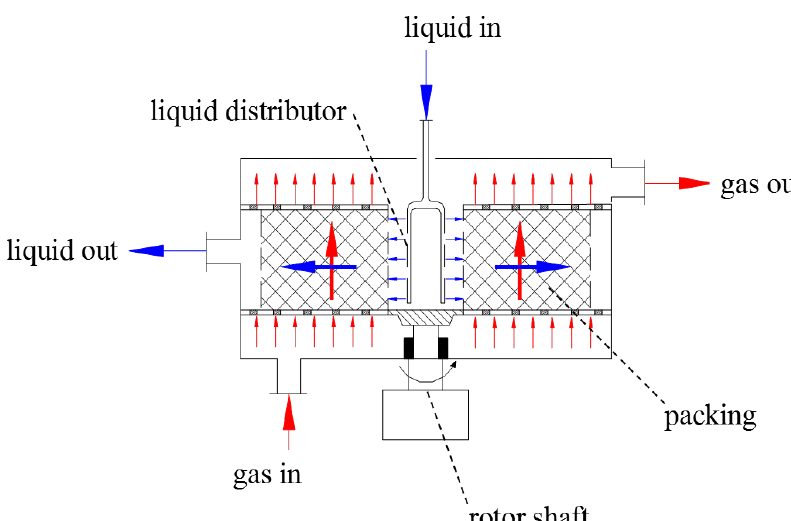
Figure 1. Main structure of a cross-flow rotating packed bed (RPB).